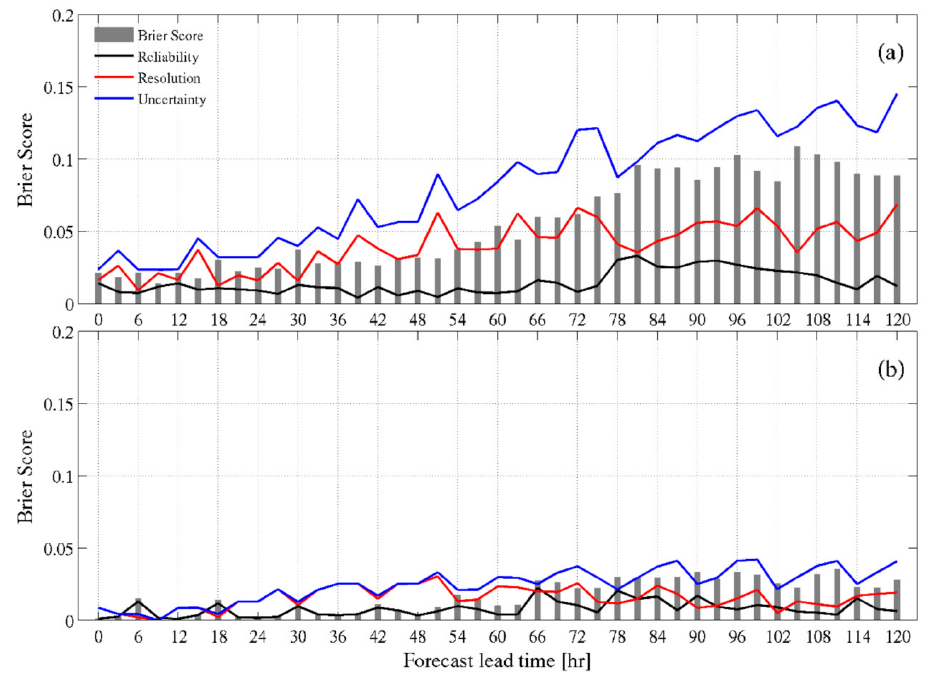
Figure 9. Comparison of the Brier score of forecast lead time according to threshold for significant wave heights of ( a ) 2 m or above and ( b ) 4 m or